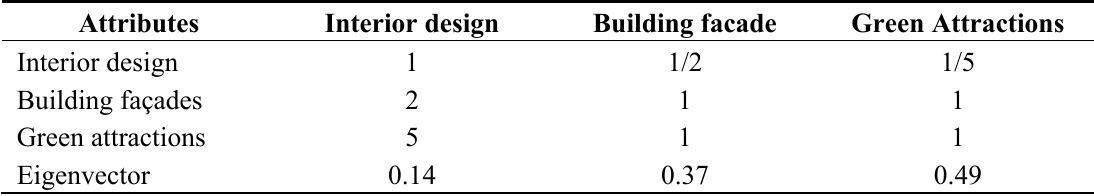
Table 1. Weighting value of the main criteria: comparison of the interior design, building facades, and green attractions.